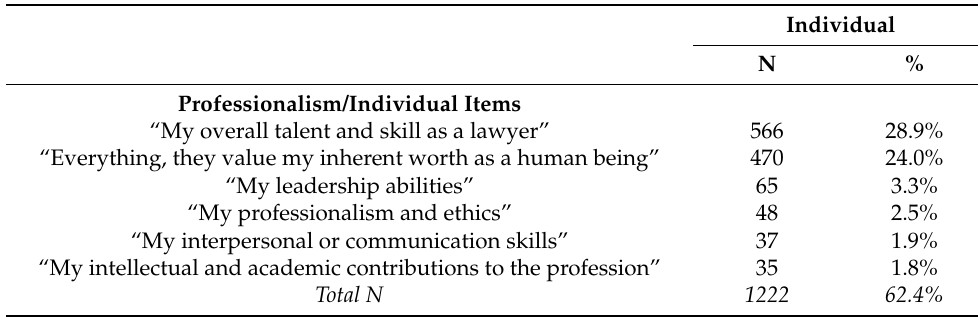
Table 1. Perceived employer value items and participant response frequency to the question, “What do you feel your employer values most about